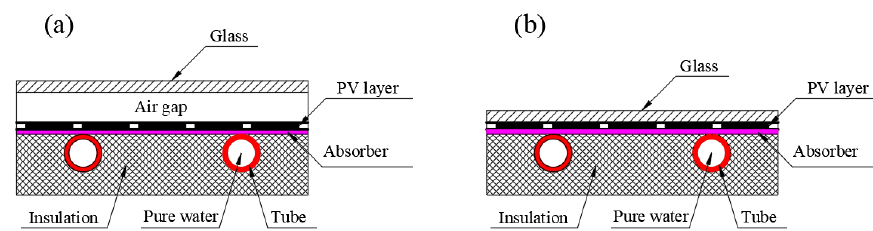
Figure 2. Cross section of PV/T module type I ( a ) and type II ( b ).